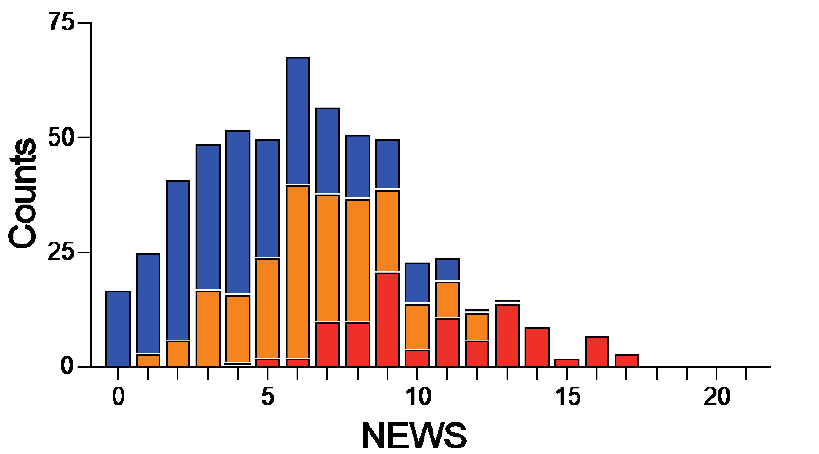
Figure 2. Distribution of patients with infection and sepsis according to NEWS. Number of pa- tients with infection without sepsis (blue bars) and sepsis with a qSOFA < 2 (orange bars) or a qSOFA ≥ 2 (red bars) for each category of NEWS.